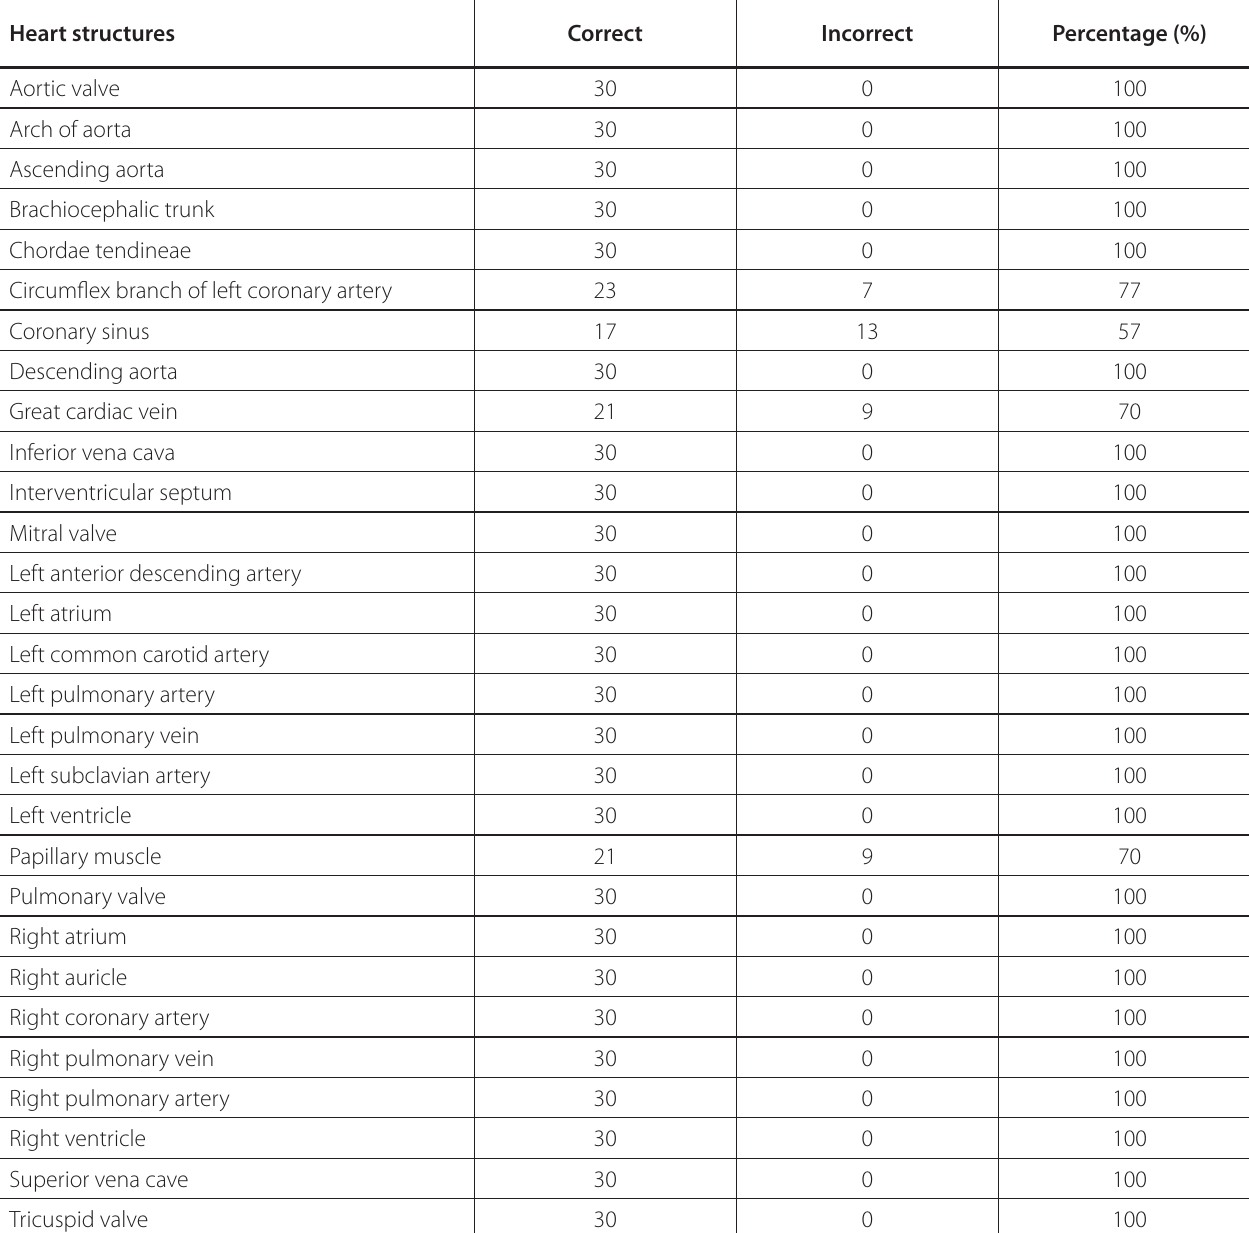
Table 1 . Identification of heart structures by clinicians